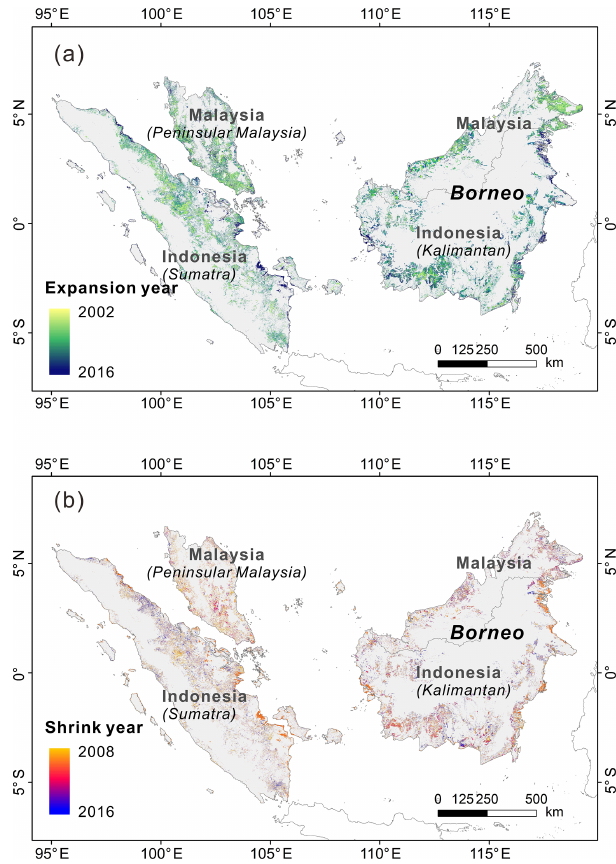
Figure 4. Year of oil palm change at 100m resolution in the study area from 2002 to 2016. (a) Expansion (2002–2016) and (b) shrink- age (2008–2016). During 2011–2014, the from–to types of the change pixels were pre-defined in the 2010 and 2015 land cover maps derived from PALSAR and PALSAR-2 data, respectively. Therefore, both the expansion and shrinkage year of oil palm were available in this period using the change-detection method. During 2001–2006, the oil palm distribution of the start year is unknown. Here we assumed one-way expansion of oil palm before 2007 and adopted the change-detection algorithms in the 2007 oil palm ex- tent. Thus, the expansion year was traced back to 2002. The grey background refers to the study